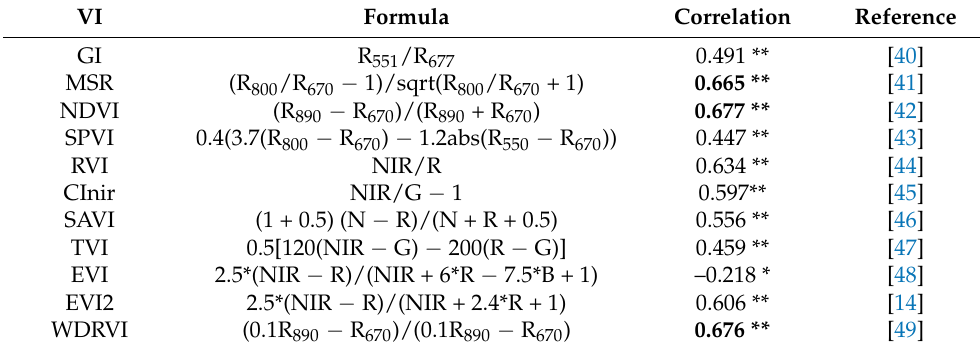
Table 2. Selected spectral indices for establishing prediction models and correlation coefficients between each spectral index and yield. Note: GI, greenness index; MSR, modified simple ratio; NDVI, normalized difference vegetation index; SPVI, spectral polygon vegetation index; RVI, ratio vegetation index; CInir, chlorophyll index; SAVI, soil-adjusted vegetation index; TVI, triangular vegetation index; EVI, enhanced vegetation index; WDRVI, wide dynamic range vegetation index. VI Formula Correlation Reference GI R 551 /R 677